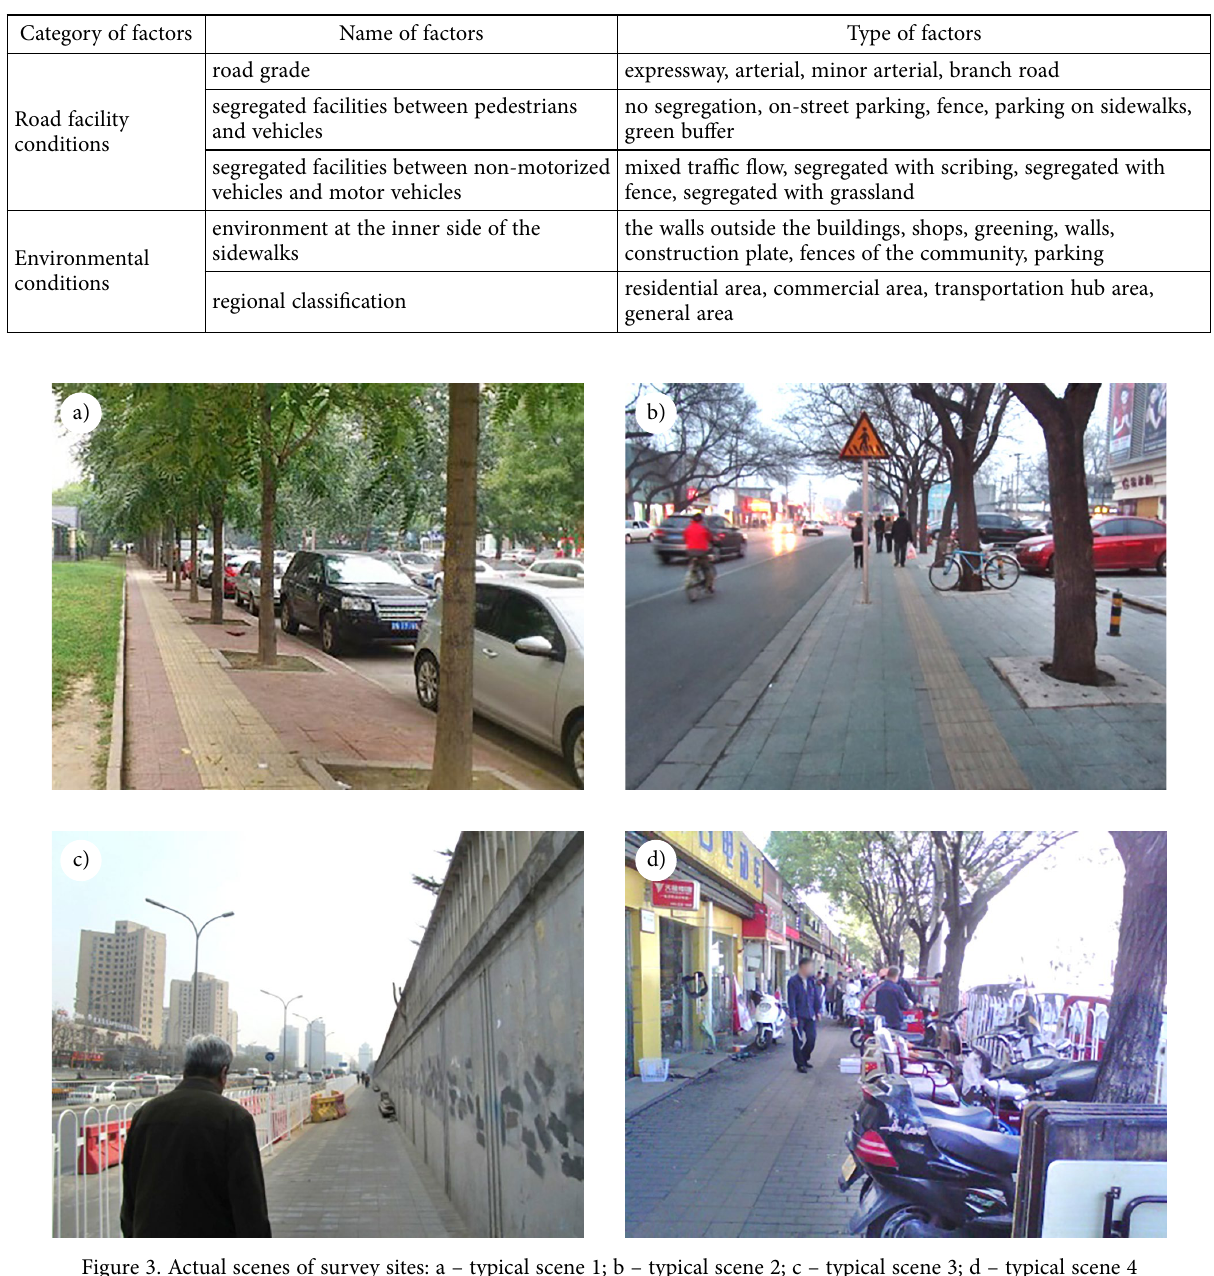
Figure 3. Actual scenes of survey sites: a – typical scene 1; b – typical scene 2; c – typical scene 3; d – typical